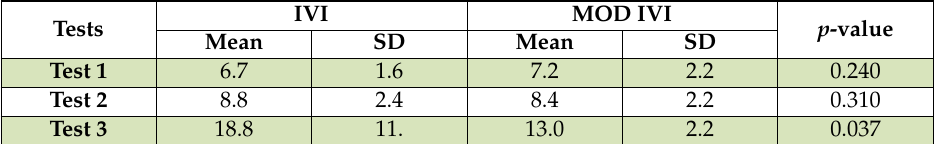
Table 2. Phase Two: integrated view input (IVI) and Modified (MOD) IVI comparison.